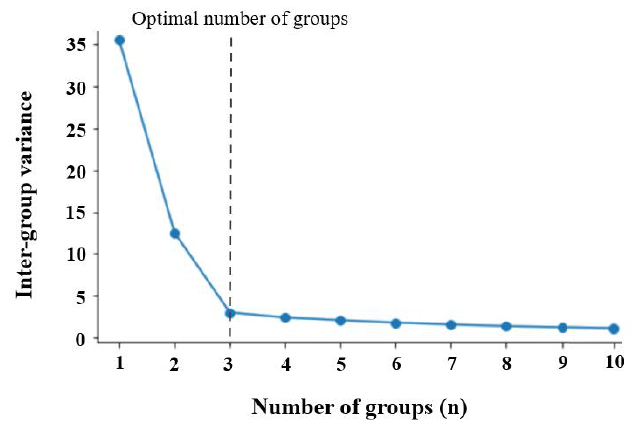
Figure 5. Optimization for number of fuzzy